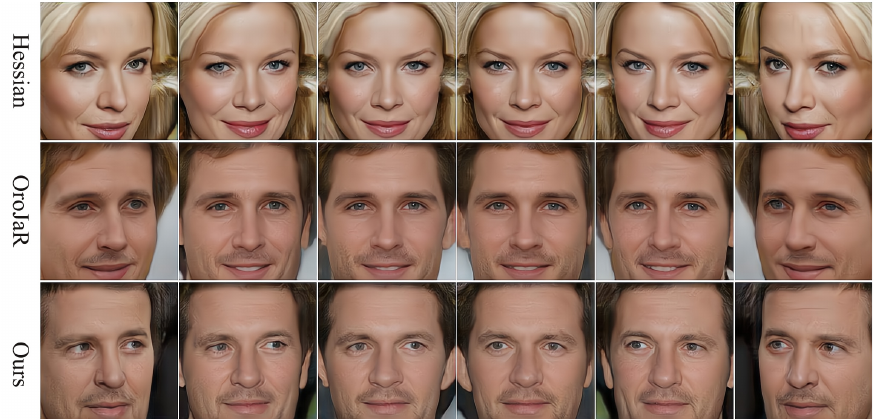
Figure 10. Comparison of rotation disentanglement of the CelebA-HQ dataset by our method, Hessian penalty [13], and OroJaR [14].